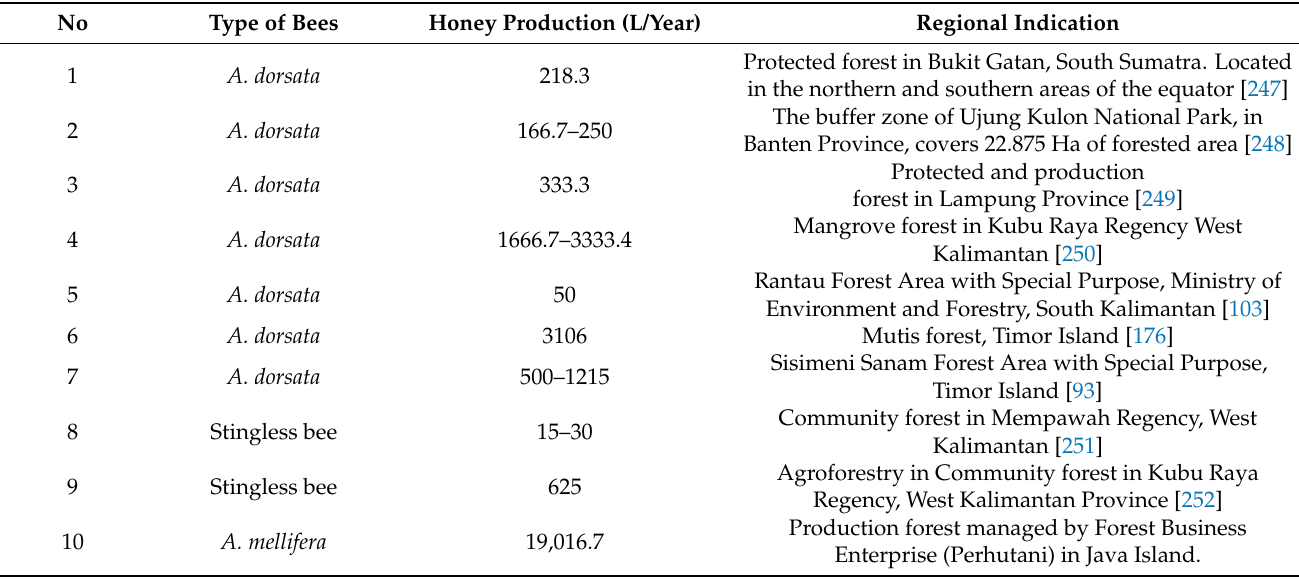
Table 2. Predicted annual honey production by